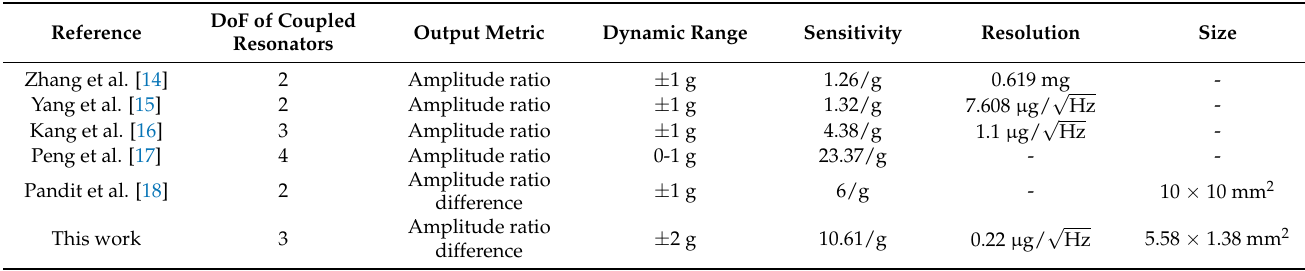
Table 2. Comparison of the 3-DoF weakly coupled resonators based MEMS accelerometers performance with respect to mode-localized MEMS accelerometers presented in the